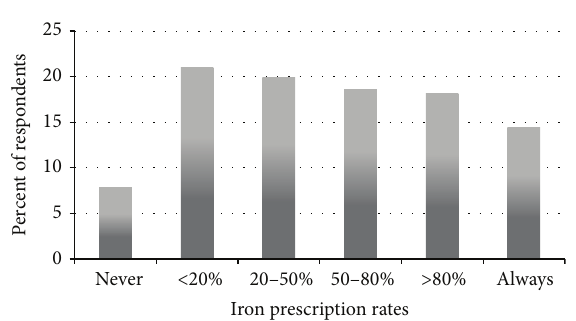
Figure 5: The percentage of clinicians who prescribe iron therapy to anemic patients after upper gastrointestinal